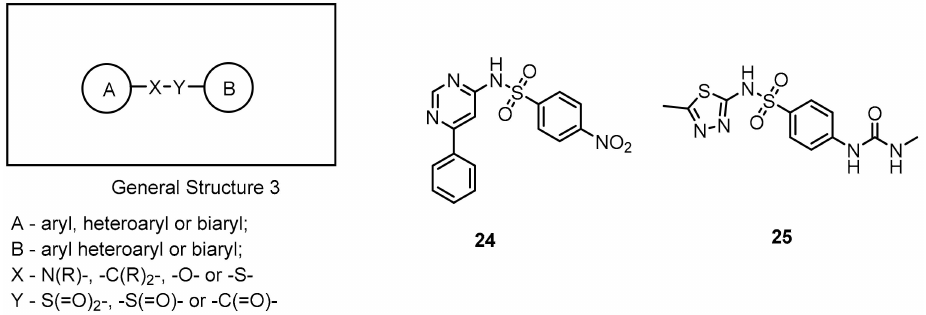
Figure 12. General structure and examples of the PD-1 / PD-L1 sulfamonomethoxine 24 and sulfamethizole 25 inhibitors